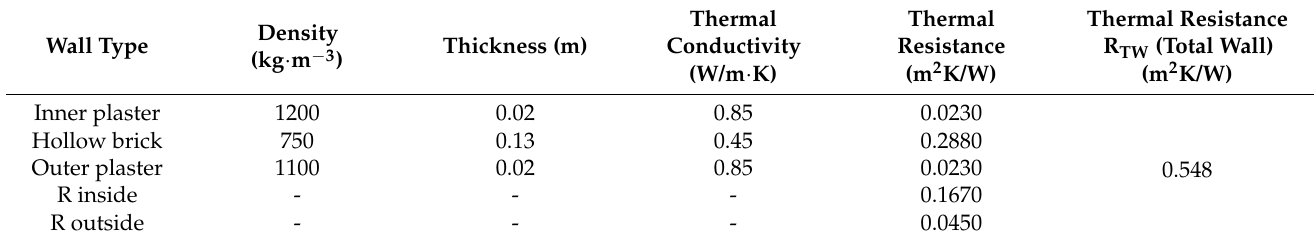
Figure 2. The exterior wall model in the study and the characteristics of its components. Table 2. Construction of walls used in the analysis [27,28].